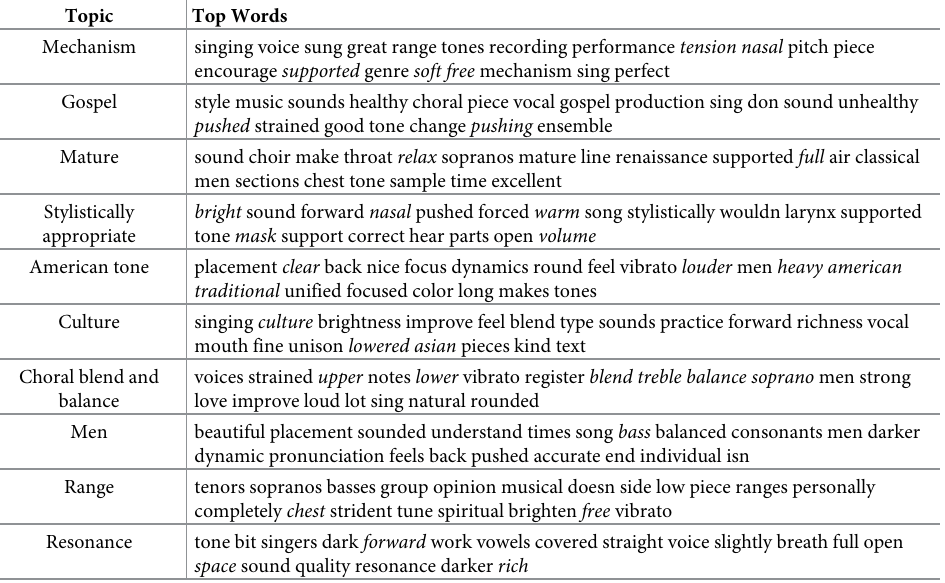
Table 6. Topic key terms for open-ended responses.